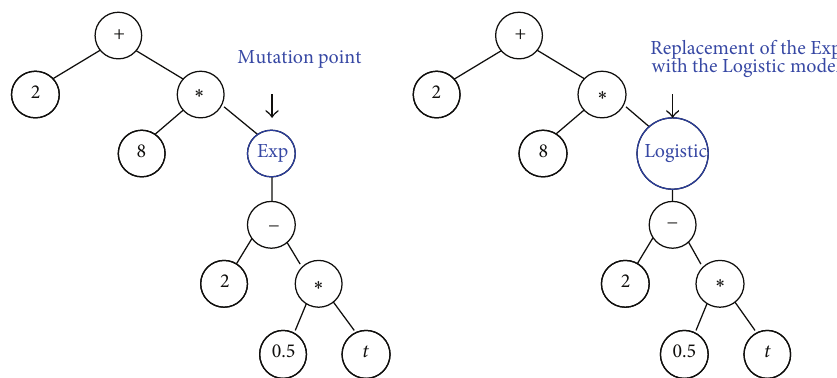
Figure 8: Mutation of the modified-hybrid Genetic Programming method (parse tree representation).